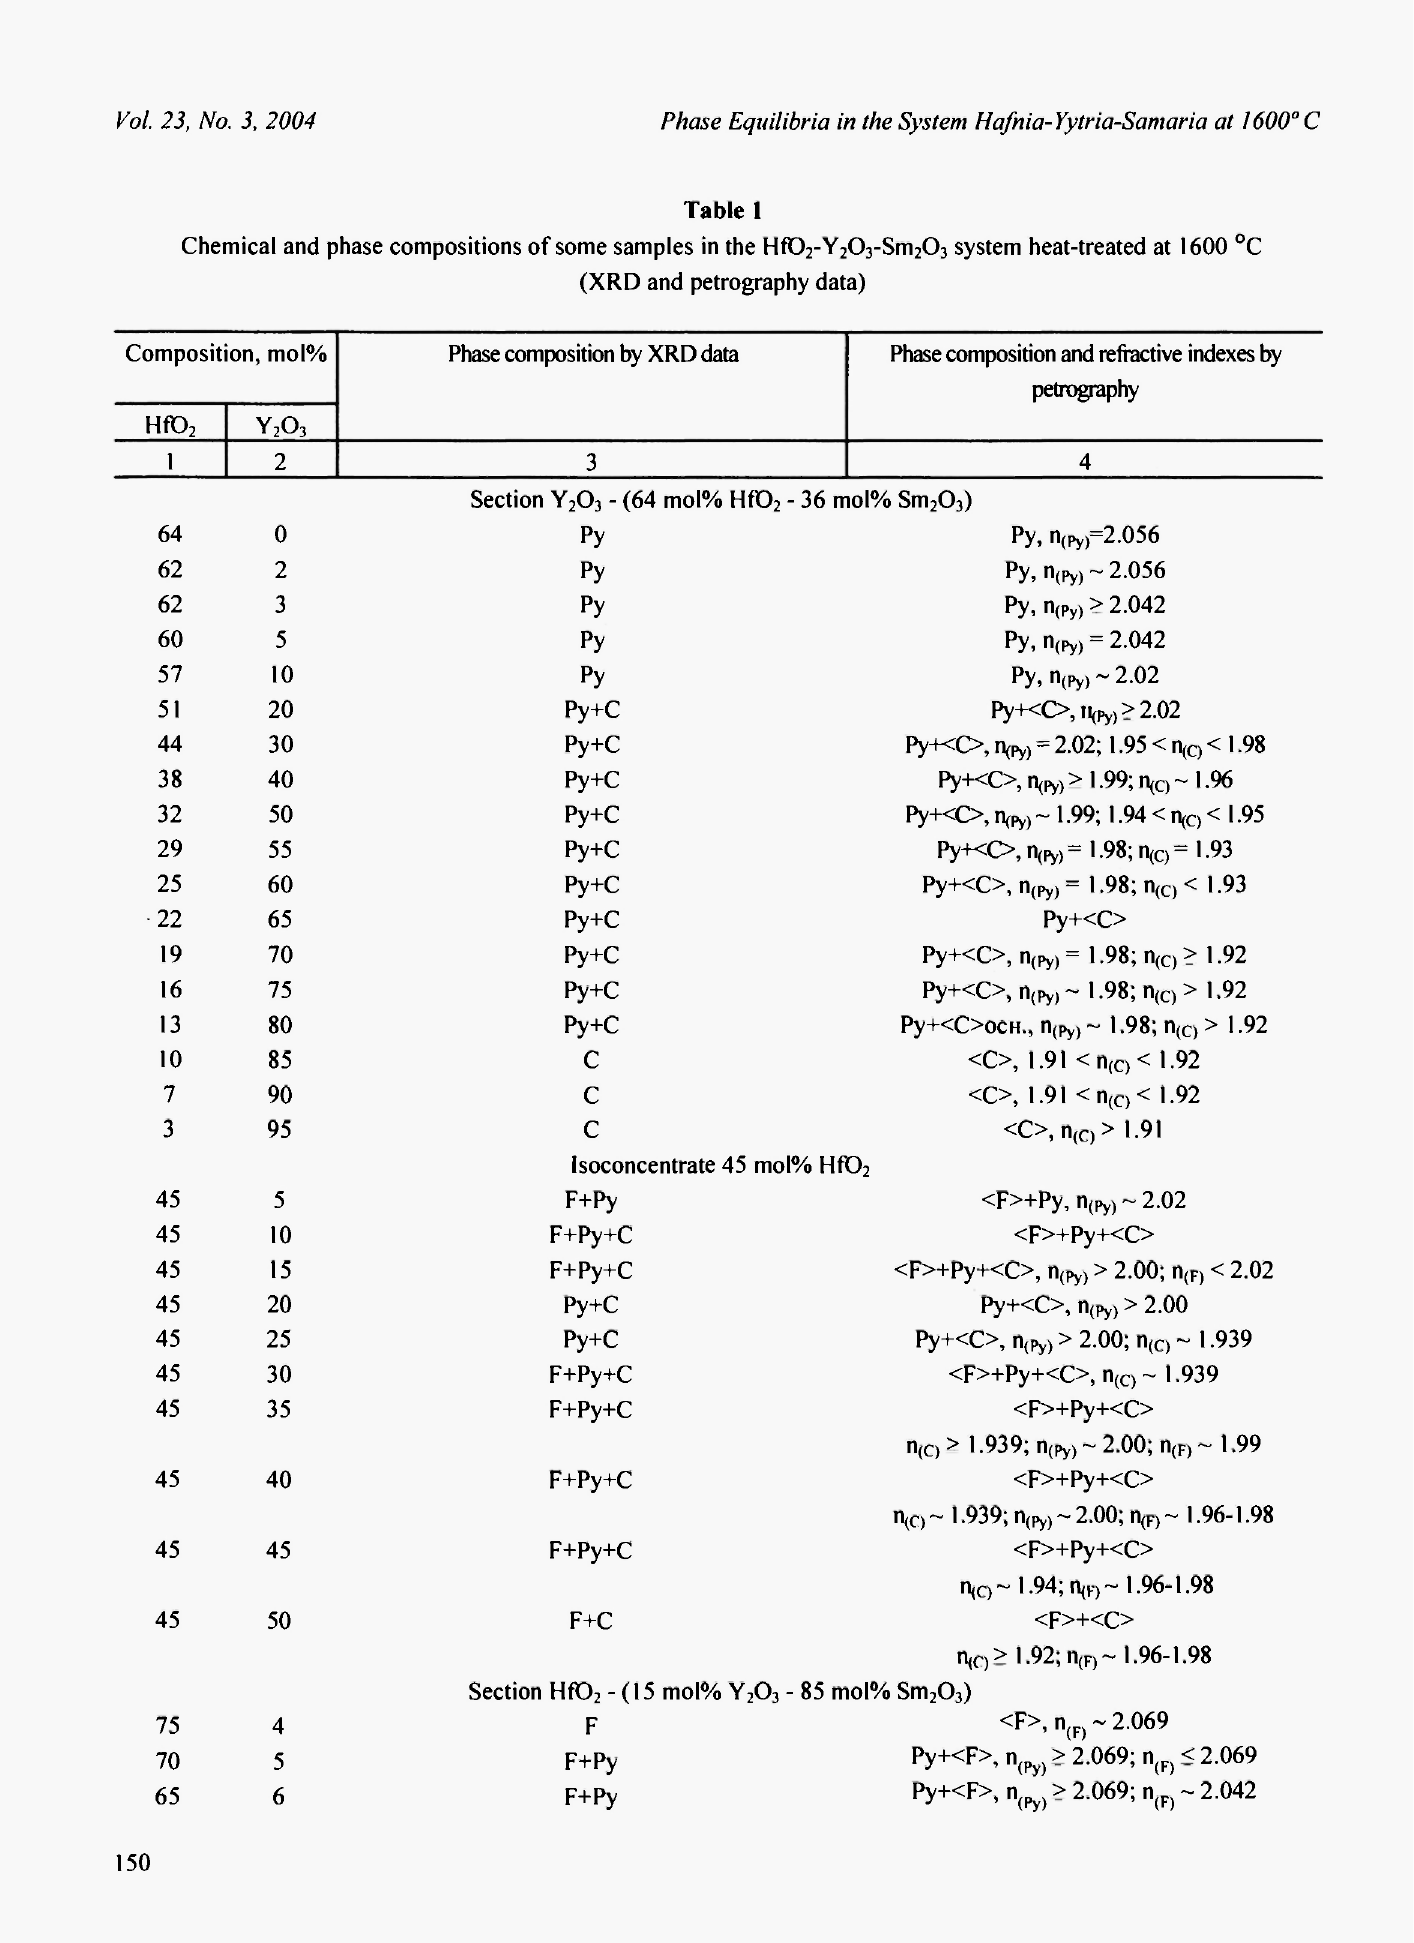
Chemical and phase compositions of some samples in the Hfö 2 -Y 2 0 3 -Sm 2 C)3 system heat-treated at 1600 °C (XRD and petrography data) Phase composition and refractive indexes